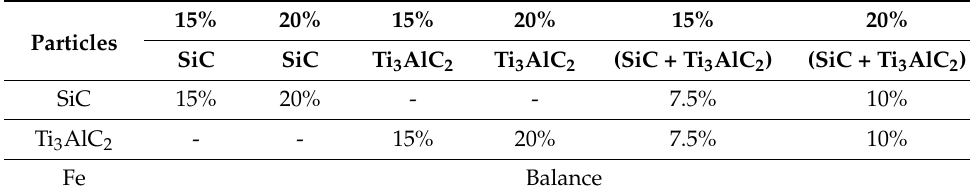
Table 1. The ratios of powders in the different samples